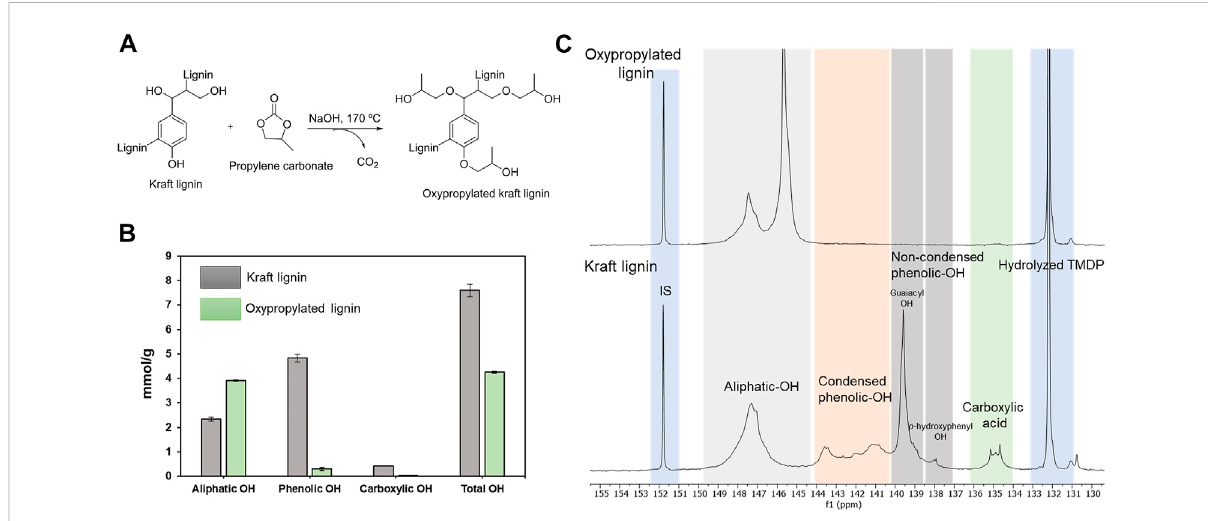
FIGURE 1 (A) Schematicreactionoftheoxypropylationofkraftlignin. (B) Distributionofaliphatichydroxyl,carboxylicacidandphenolichydroxylgroupsin kraftligninandOxypropylatedlignin.Errorbarsshowthestandarddeviationfromtheaveragevaluesobtainedfromtworeplicatesofthequantitative 31 P NMR experiments. (C) 31 P NMR spectra of Oxypropylated kraft lignin (top) and kraft lignin